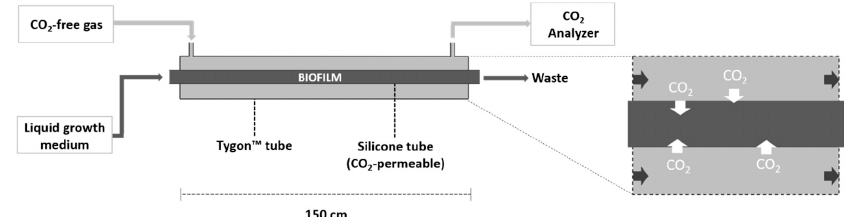
Figure 1. Schematic of the biofilm reactor (BR) module. Liquid medium is pumped into the silicone tube where inoculation and subsequent biofilm growth occur. The annular space created by the Tygon™ tube is used for gas channeling (dark arrows). CO 2 molecules can readily pass between the dry, gaseous environment in the annular space and the aqueous environment inside the silicone tube (white arrows). The CO 2 analyzer downstream continuously monitors the CO 2 concentration in the gas stream. Table 1. CO 2 sequestration monitoring system (CSMS) properties and operating conditions.